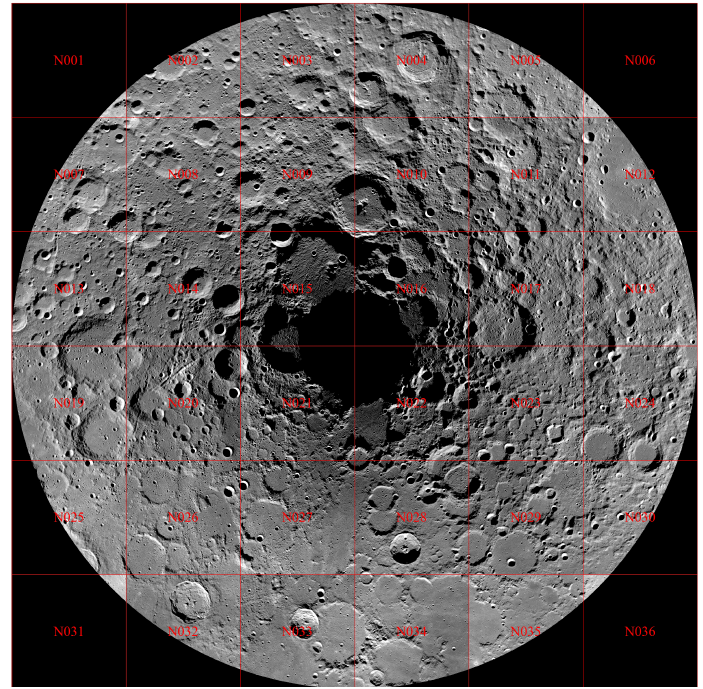
Figure 11. The arctic framing diagram of Chang’e